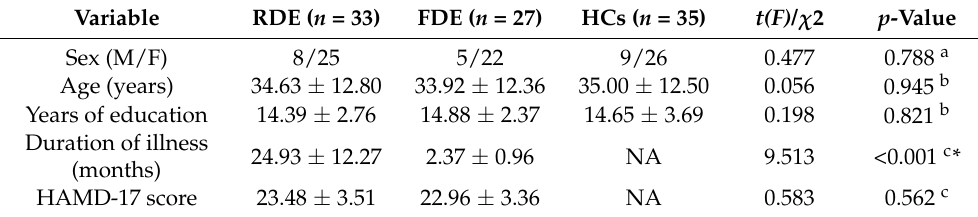
Table 1. Demographic and clinical characteristics of the study participants.